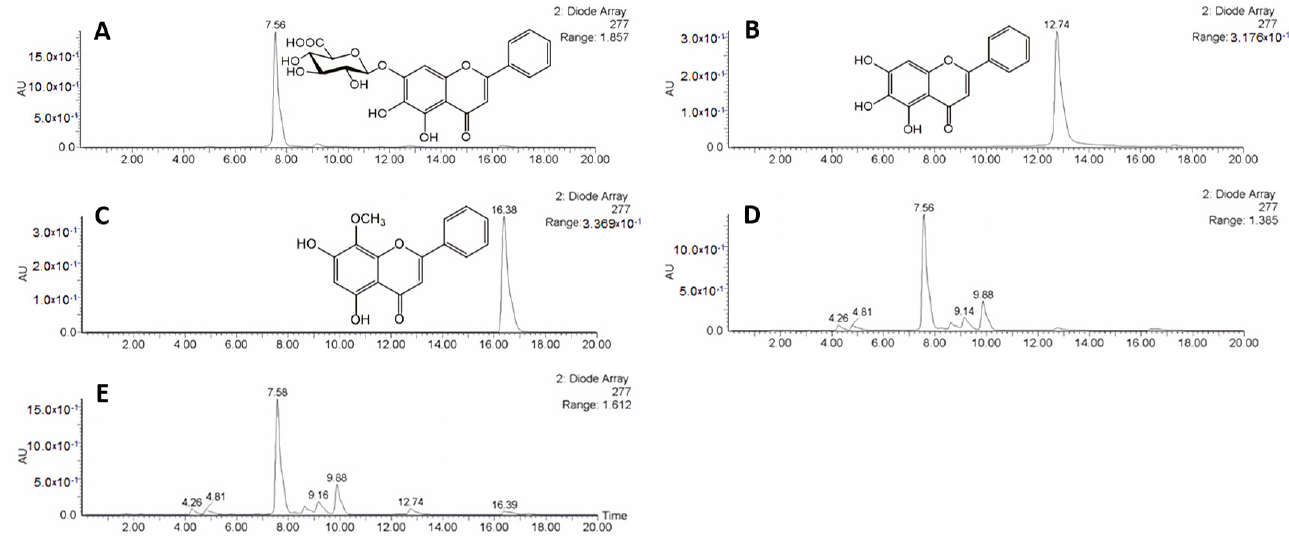
Figure 1. Liquid chromatography–mass spectrometry chromatogram and cell viability. ( A ) Baicalin, ( B ) Baicalein, ( C )